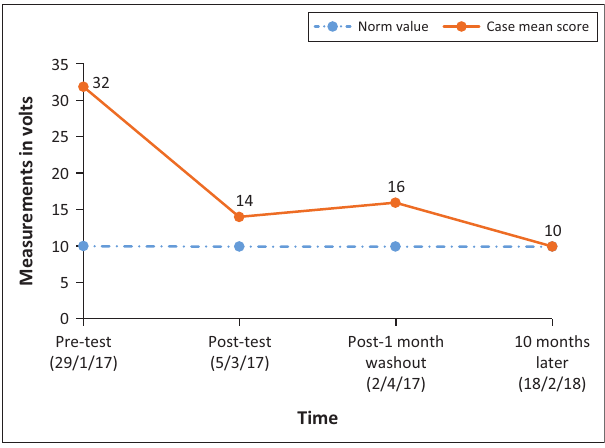
FIGURE 1: Supine position: change in mean vibratory perception threshold scores (volts) over